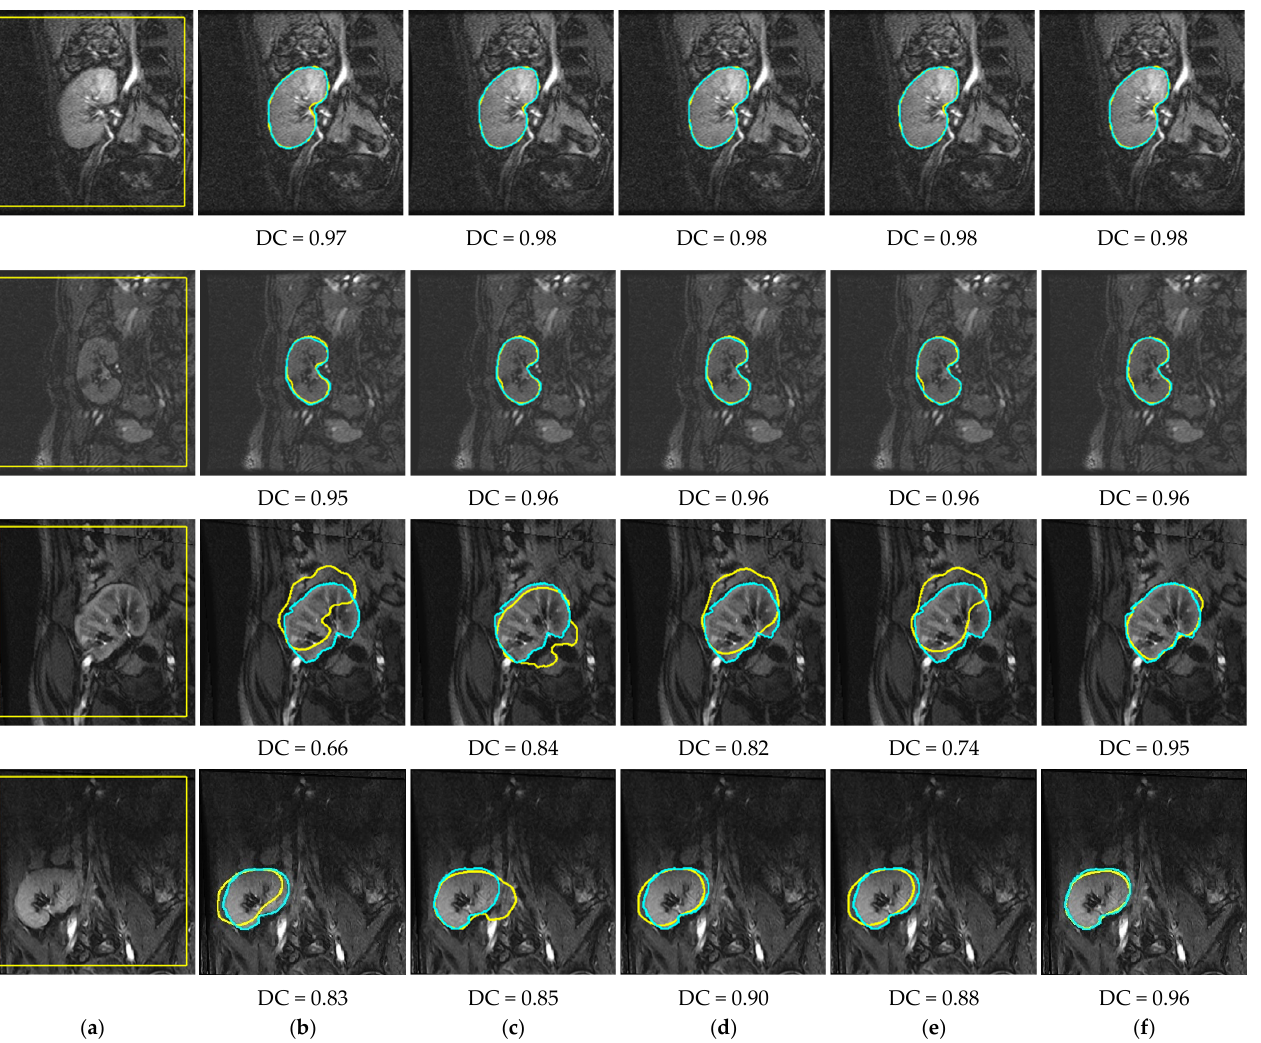
Figure 8. Output segmentations by the proposed approach and other existing LSet-based methods. ( a ) Input image with initial LSet contour. Results shown in yellow of the ( b ) FCMLS method [11], ( c ) PBPSFL method [12], ( d ) PSFL method [13], ( e ) FML method [17], and the ( f ) proposed ap-